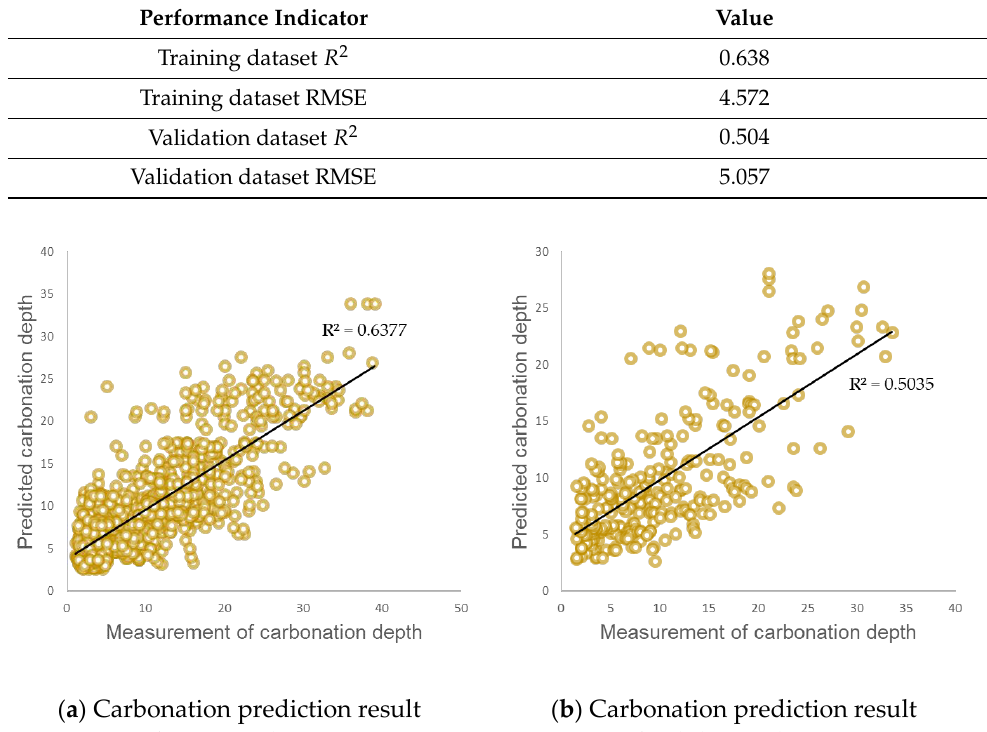
Figure 8. Carbonation prediction results of the LSTM model for the ( a ) training and ( b ) validation datasets.